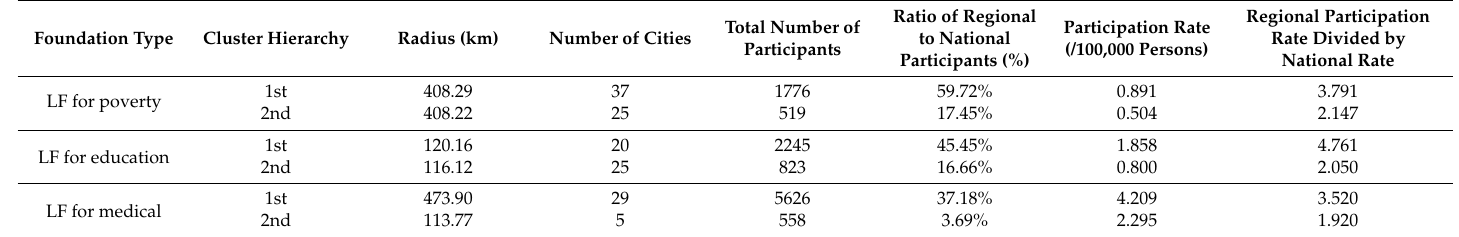
Table 2. Statistical summary of the charity participation rate in spatial cluster areas.